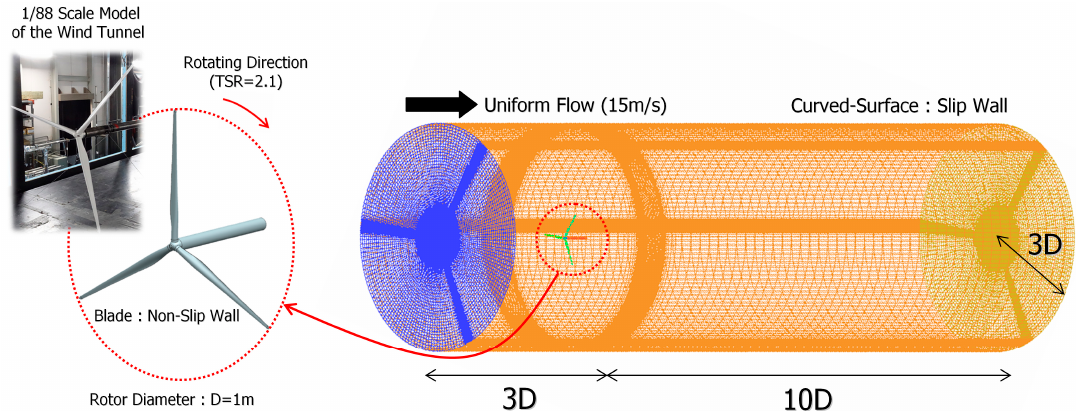
Figure 6. Computational domain and computational grid simulation of a wind tunnel experiment using a 1 / 88 scale wind turbine model, using the fully resolved geometries combined with large-eddy simulation (LES) simulations approach, produced by ANSYS(R) CFX(R).